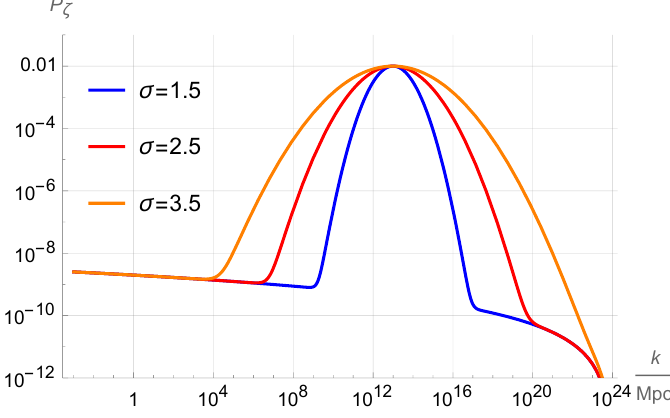
Figure 1. The power spectrum with the parameters P 0 = 6.57 × 10 − 13 , k peak = 10 13 Mpc − 1 , k final = 7.7 × 10 23 Mpc − 1 for σ >